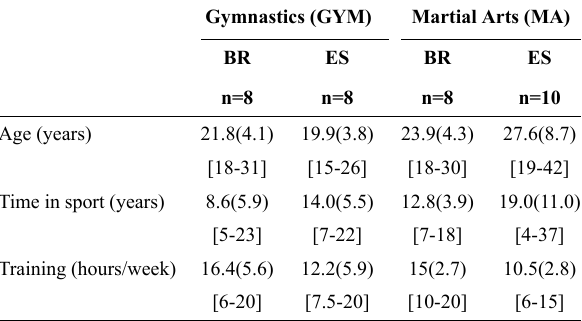
Table 1 - Characteristics of gymnastics and martial arts athletes.